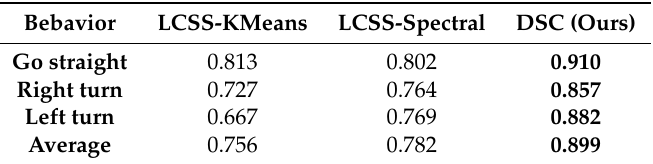
Table 5. The results of vehicle trajectory clustering for behavior recognition. For each type of behavior, we show the accuracy on each type and the average value (higher is better). The best values are highlighted using a bold